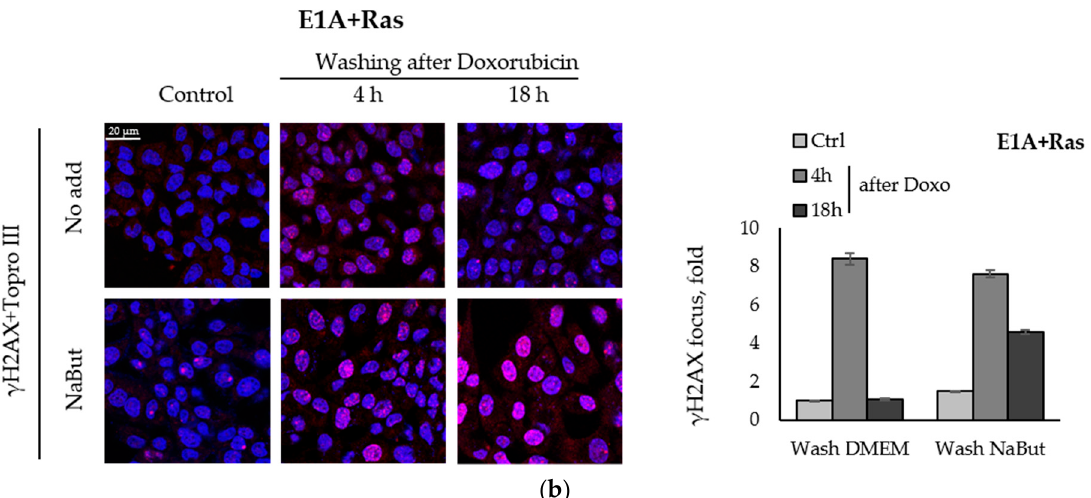
Figure 2. NaBut prolongs a doxorubicin-induced γ H2AX foci persistence in transformed cells. Immunofluorescence analysis of γ H2AX foci presence in non-transformed NIH3T3 cells ( a ) and in oncogene-transformed E1A+Ras cells ( b ). Cells were left untreated (Control,Ctrl) or treated with 0.2 µg/mL doxorubicin for 40 min and washed with DMEM with or without NaBut (NaBut/Ctrl) for 2–18 h. Cells were stained with rabbit anti- γ H2AX antibodies, followed by Alexa-fluor 563 anti-rabbit (red) and Topro III (blue) staining. The images were obtained using an Olympus FV3000 microscope (40× lens). The integrated density of immunofluorescence data was evaluated using Image J © soft, scaled to the untreated control, and then plotted. Error bars indicate ± standard error of the mean.